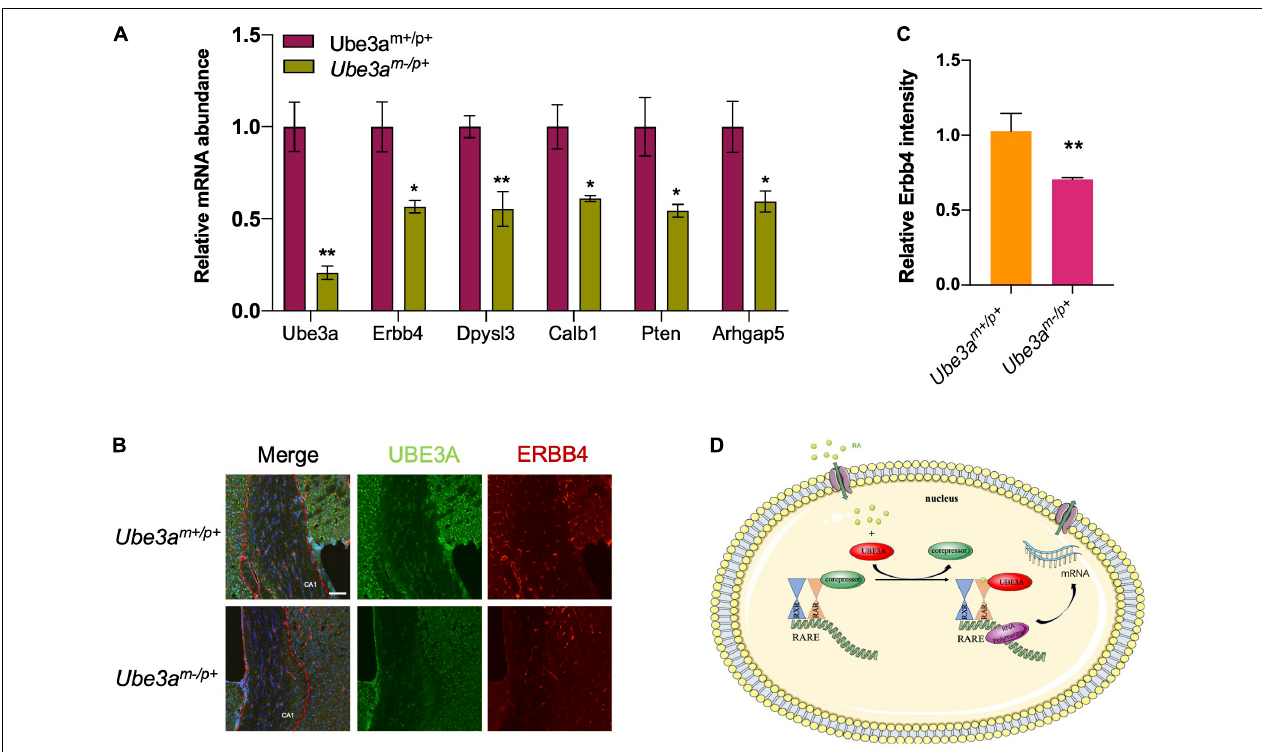
FIGURE 4 | Loss of UBE3A expression leads to the dysregulation of RA-targeted genes. (A) Endogenous RA-related genes were reduced in the Ube3a deficient hippocampus. The mRNA levels of target genes were quantitated by real-time qPCR in mouse hippocampal tissues. (B) Representative images of Erbb4 staining in hippocampal coronal slices. CA1 region was marked by the red dotted line. Scale bar, 50 µ m. (C) Quantitated intensities of ERBB4 in the hippocampal region of wild-type and Ube3a deficient mice. (D) A working model depicting how UBE3A acts as a coactivator of RAR α to participate in the regulation of RA signalling. The values are expressed as the means ± SEM from at least three independent repetitions. * P < 0.05, ** P < 0.01 , *** P < 0.001 . (B,D) Unpaired two-tailed t test, (A) one-way ANOVA with Bonferroni post hoc